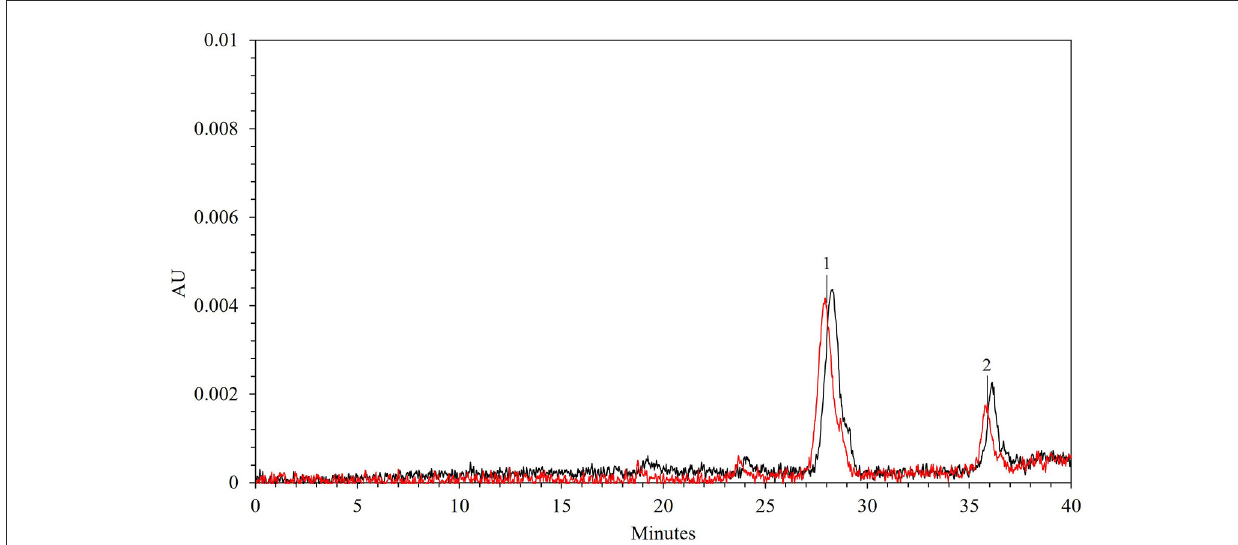
FIGURE8 HPLC-PDA chromatograms of 50% (v/v) ethanol-water extracts obtained after 300min of extraction at 50 ◦ C from untreated (red line) and PEF (E opt = 4.6 kV/cm; W T,opt = 20kJ/kg)-treated (black line) red grape pomace. Peak identification: (1) peonidin 3-O-glucoside; (2) unidentified